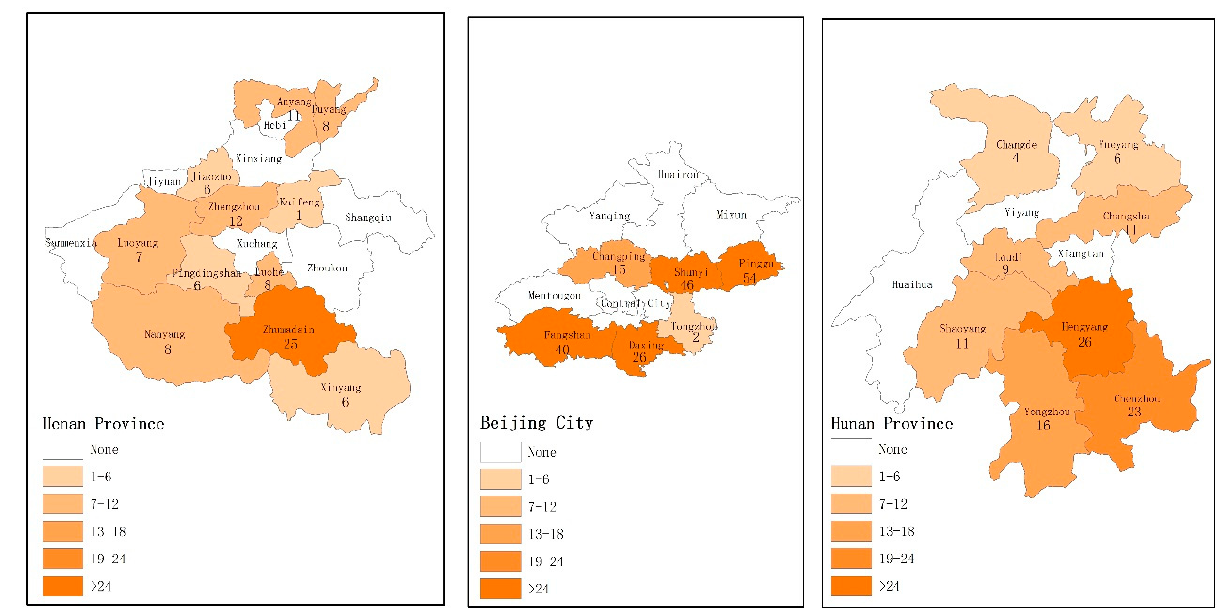
Figure 2. Geospatial distribution of the sample. Note: the central urban area of Beijing City includes six urban areas, namely Haidian, Chaoyang, Dongcheng, Xicheng, Shijingshan, and Fengtai. Basic characteristics of the samples are shown in Table 3. From the perspective of gender, the majority of the respondents are male, accounting for 81.31%. From the per- spective of age, the respondents aged 40–59 accounted for 77.78% of the total sample number, people aged 18–39 only account for 10.10%, and aged 60 years old and above account for 12.12%. Pig breeding is a heavy task that the young are reluctant to engage in, and it is also difficult for the old, so most practitioners are middle-aged people. From the perspective of educational background, nearly half of the respondents have